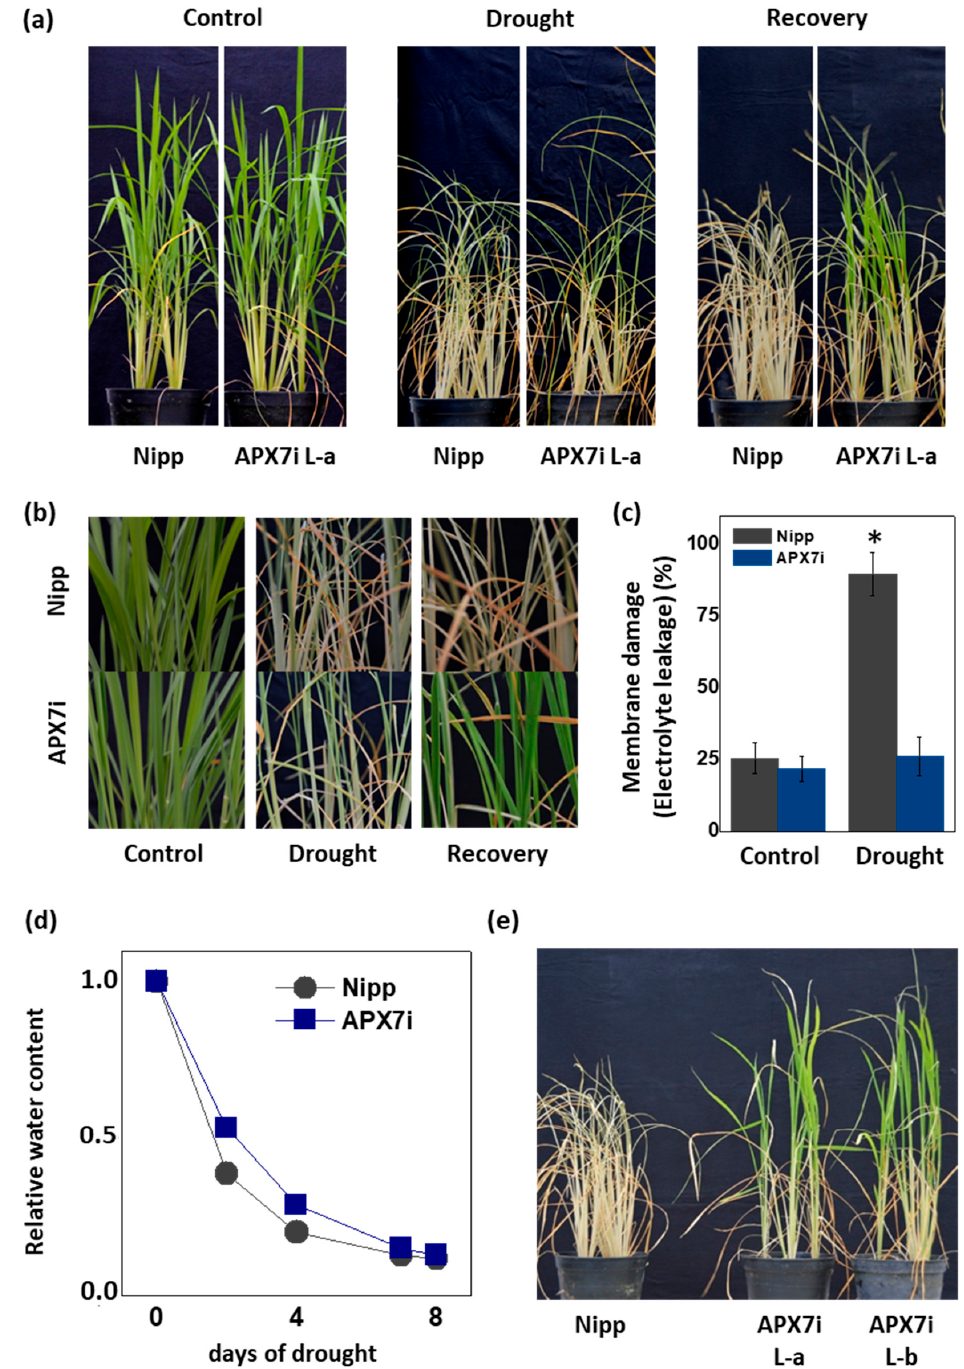
Figure 5. Effect of the OsAPX7 knockdown in drought stress tolerance. ( a ) Drought stress treatment in Nipponbare (Nipp) and APX7i plants. One-month-old plants (left panel) were subjected to eight days of drought (middle panel) and then recovered for three days (right panel). ( b ) Closer pictures of plants are shown in ( a ). ( c ) Membrane damage of Nipp (grey) and APX7i plants (blue) subjected to drought stress. ( d ) The relative water content of the soil in Nipp and APX7i plants subjected to drought stress. ( e ) Drought stress response in different lines of APX7i plants. One-month-old plants were subjected to eight days of drought and then recovered for three days. All values represent the average ± SE of at least four independent experiments. * indicates populations significantly different from the control situation with p <